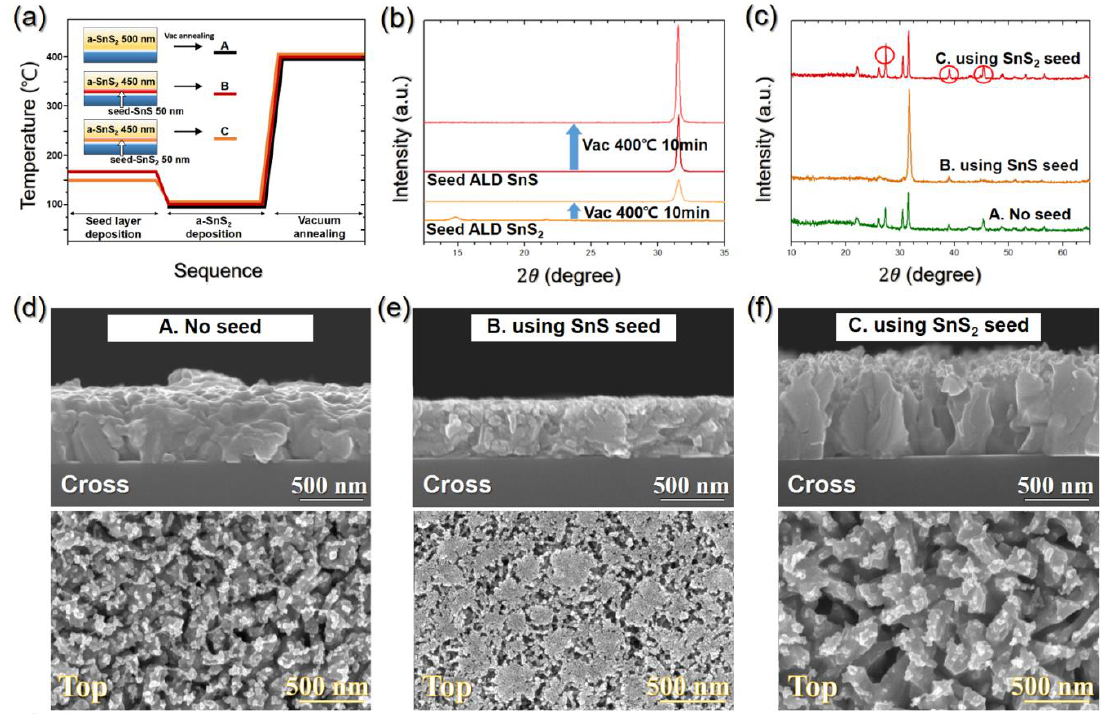
Figure 5. ( a ) Schematic diagram of the SnS film process sequence with a seed layer. ( b ) XRD patterns of seed layers and vacuum annealing result of seed layers. ( c ) XRD patterns of the SnS films with various seed layers. ( d–f ) SEM images of SnS films obtained by annealing a-SnS 2 films, including various seed layers, at vacuum atmosphere.